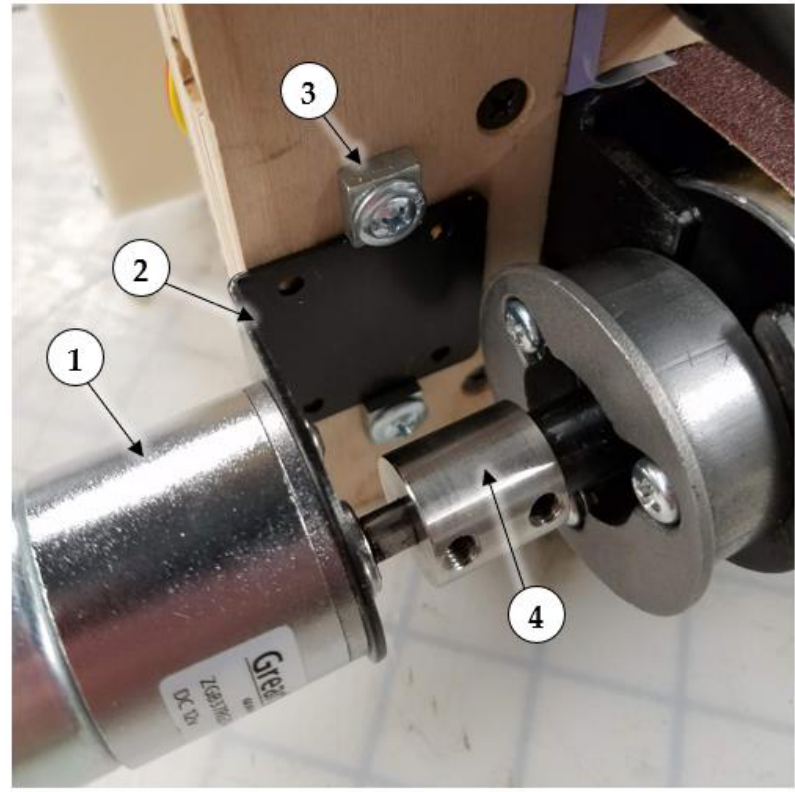
Figure 3. Assembled (1) gearmotor, (2) L-shaped torque arm bracket, (3) torque arm stops, and (4) 12 mm to 6 mm shaft coupling. (4) 12 mm to 6 mm shaft